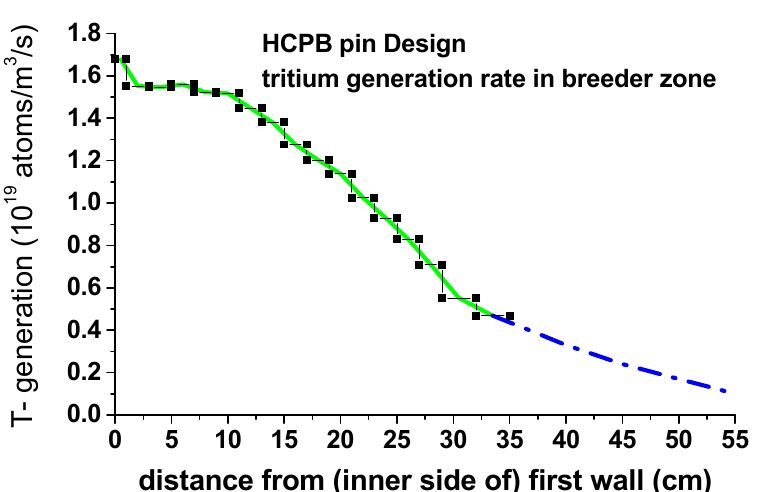
Figure 4. 1D tritium generation rate from MCNP calculations [13]. Green: interpolated data for inboard pin; blue: extrapolated data for outboard pin.